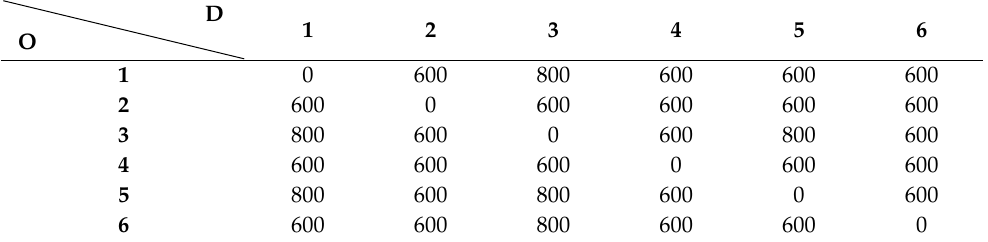
Table 1. Travel demand of the network.